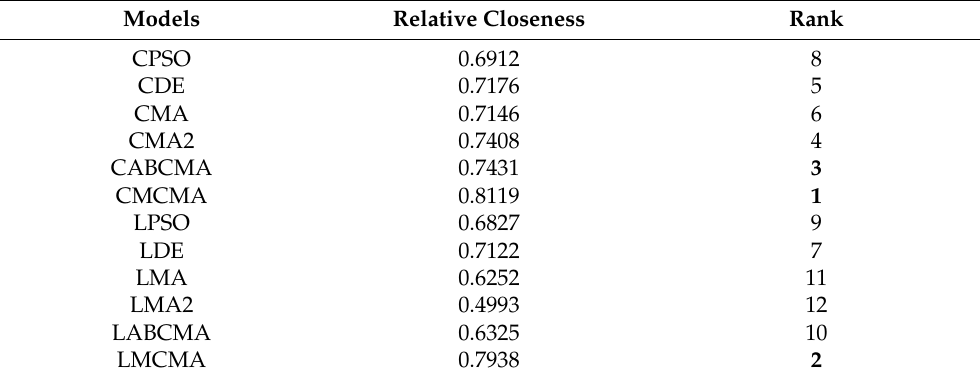
Table 7. Ranking for BTC/EUR dataset.